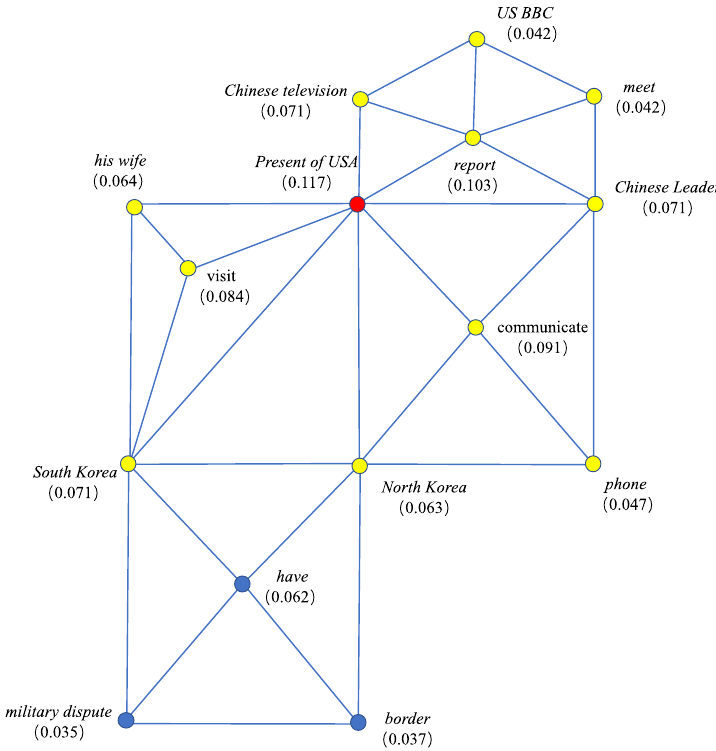
Figure 3. PageRank values of the nodes in the event connection graph.